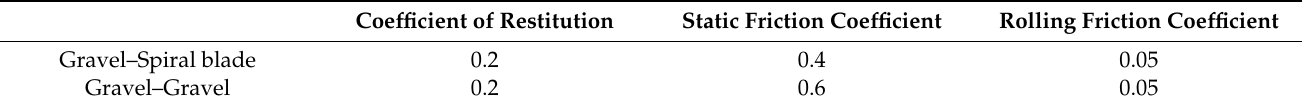
Table 4. Interaction coefficient between gravel and spiral.